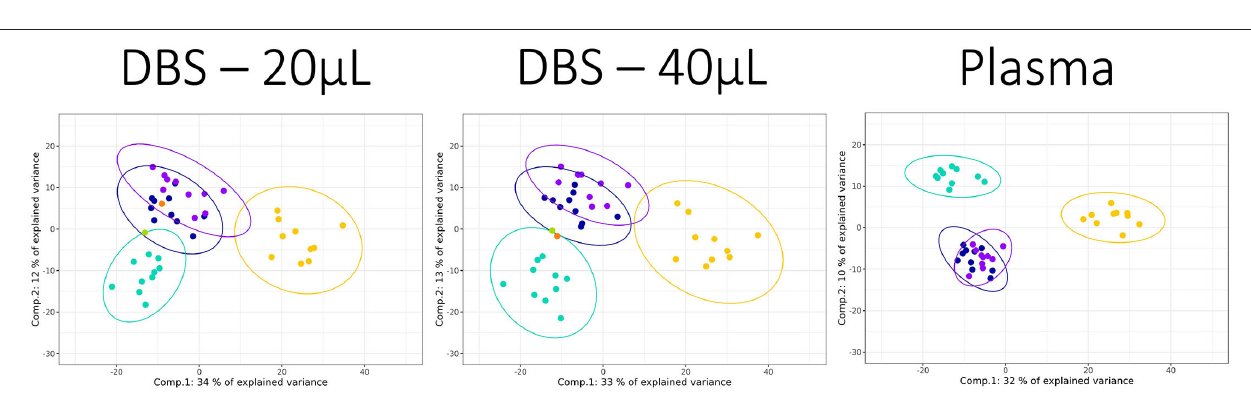
FIGURE 1 | Principal component analysis (PCA) scores plots (PC1 vs. PC2) for data collected for three sample types applying the HILIC positive ion mode assay. The sample classes are pooled QC: yellow; domestic short hair cat: green, Norfolk terrier: light blue, Labrador retriever: dark blue, Beagle: red, and Petit Basset Griffon Vendeen: pink. The PC1 and PC2 variances were 31.1 and 8.2% (dried blood spot, DBS, 20 µ L), 30 and 7.9% (DBS 40 µ L), 25.5 and 7.5% (plasma).